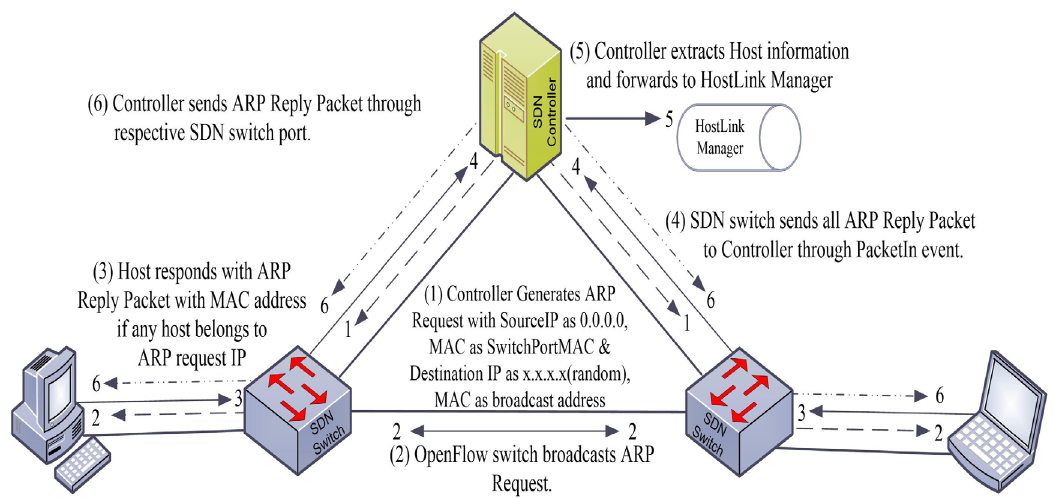
Figure 2. Algorithm and Flow Diagram for IdeA.